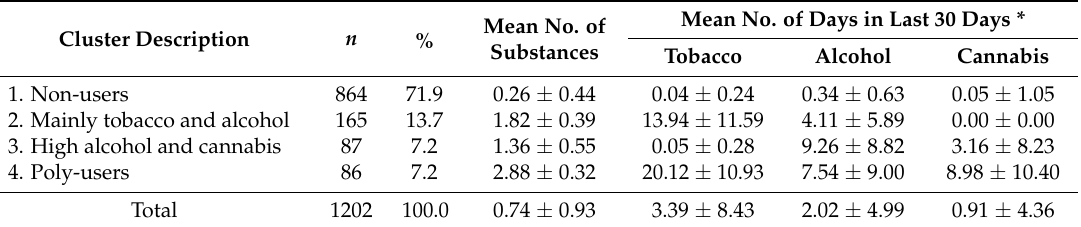
Table 1. Patterns of psychoactive substances use in order to their prevalence in population. Mean No. Cluster Description n %